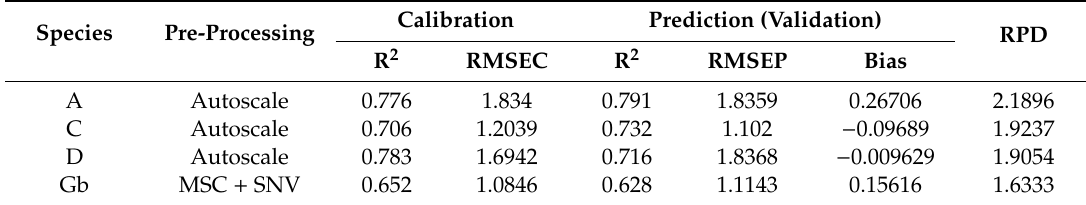
Table 10. Best results of species with second derivative data and their preprocessing at a spectral sampling range of 729–975 nm using SVM-R.